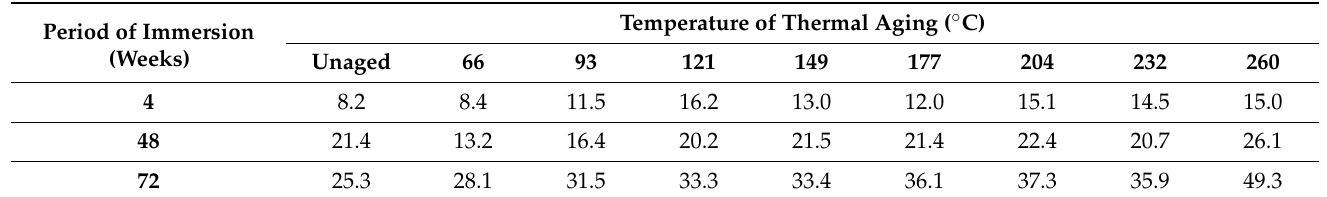
Table 2. Level of deterioration in SBS strength due to immersion in deionized